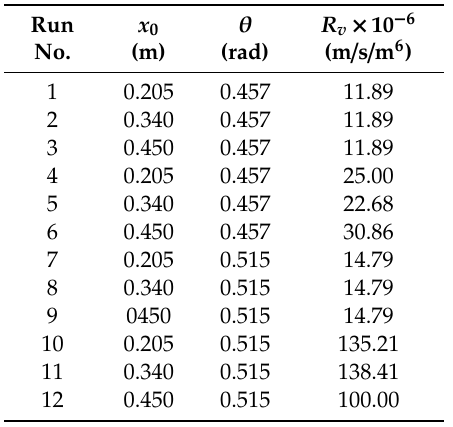
Figure 4. Used experimental facility. Table 1. Characteristics of runs.